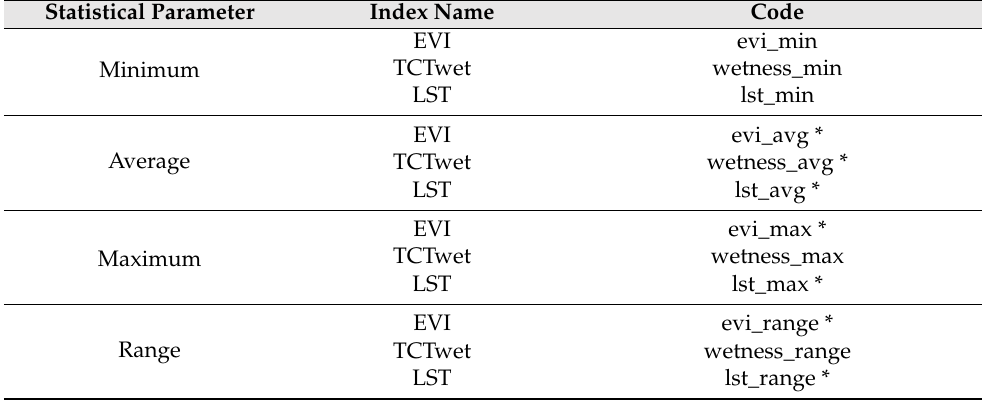
Table A3. Acronyms of the remote sensed ecosystem functioning variables (defined in Table 1), by statistical measure. (*) indicates the variables used in the models after the correlation analysis. Statistical